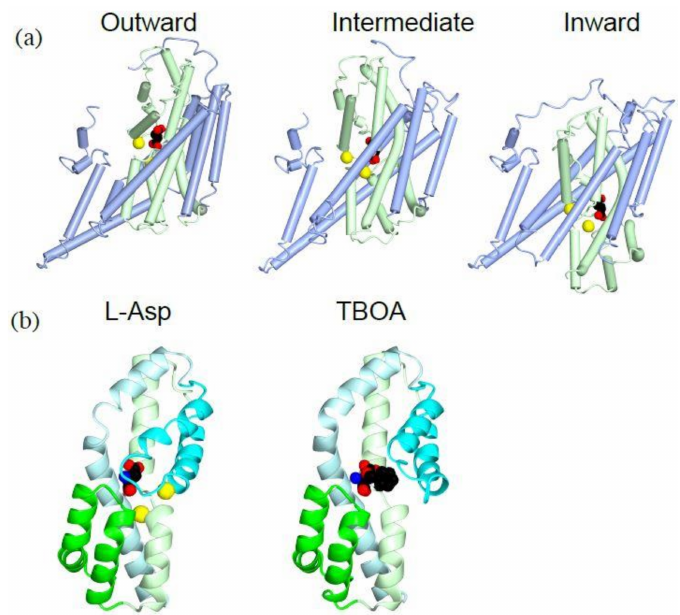
Figure 3. Crystal structures of GluTPh showing transport mechanism of a glutamate transporter: ( a ) Tube and worm diagrams showing the three stages of GluTPh during transport. Left, outward-occluded, PDBID:2NWX; middle, intermediate, PDBID 3V8G; right, inward-occluded, PDBID:3KBC. The trimerization domain is in light blue, and the transport domain is in light green with L -aspartate (spheres) and a sodium ion (yellow). The orientations of the trimerization domain of each structure are aligned. ( b ) Ribbon diagram of a transport domain core structure with HP1 (green), HP2 (cyan), TM7 (light green) and TM8 (light cyan). Left, L -aspartate (spheres) and sodium ions (yellow), PDBID:2NWX; right, TBOA (spheres),